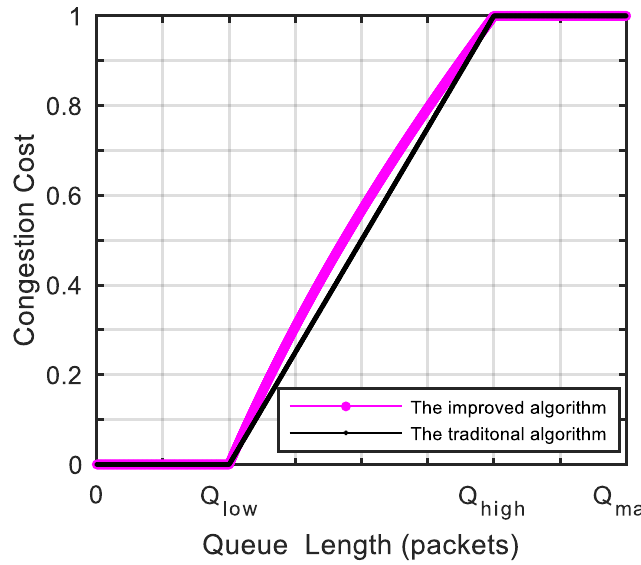
Figure 3. Relationship between congestion cost and queue length.